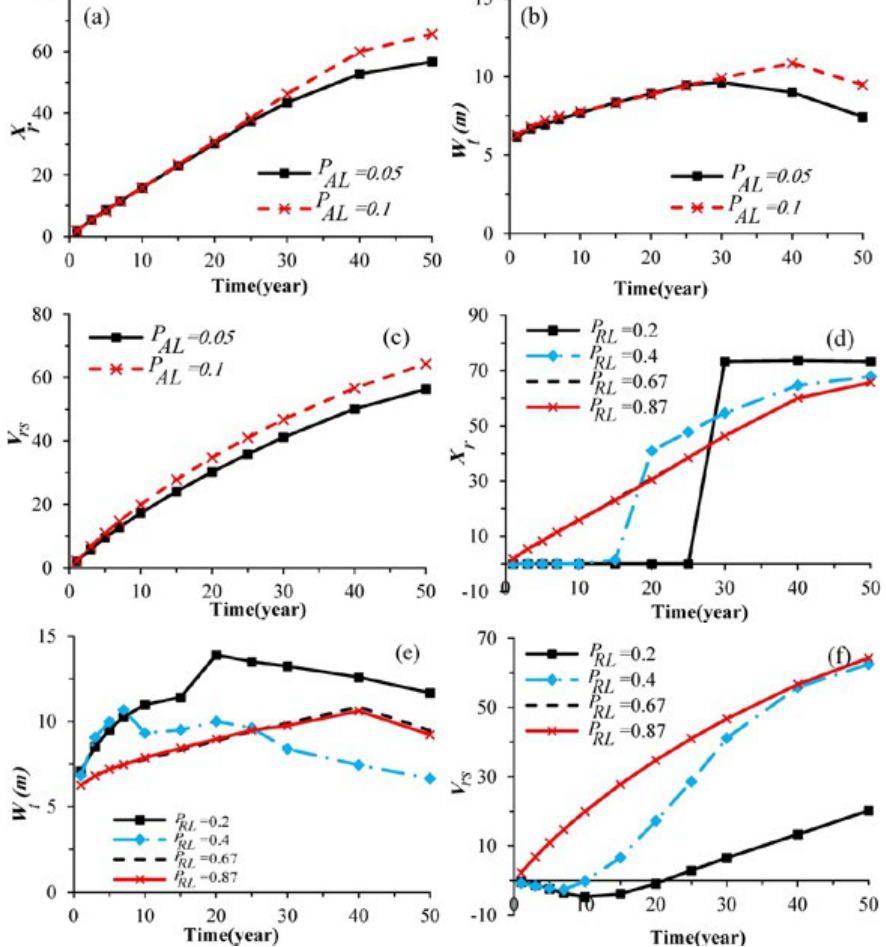
Fig. 2: The ADR efficiency (a), (b) and (c) for different abstraction well distance from shoreline and (d), (e) and (f) for different recharge well distance from shoreline